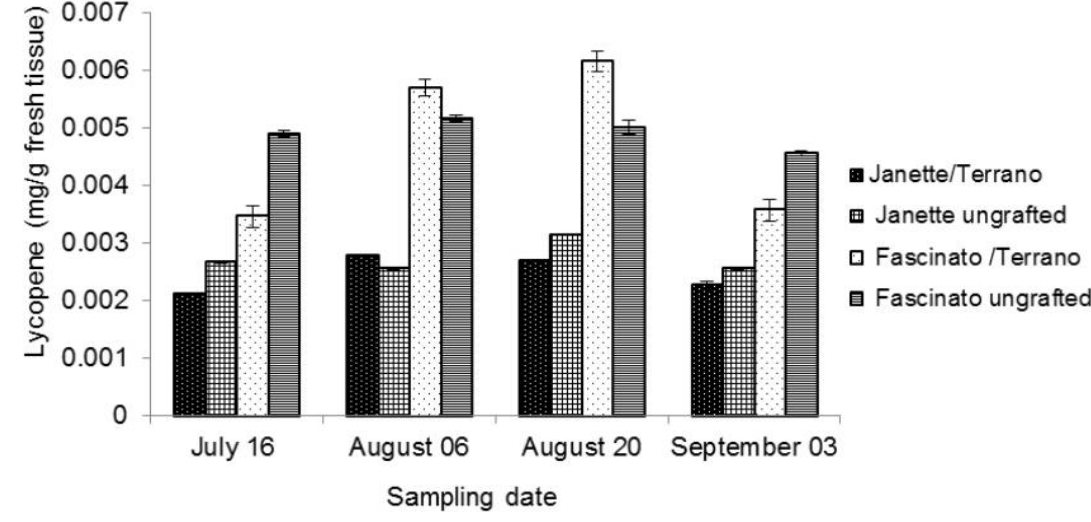
Figure 3. Lycopene concentration in two bell pepper varieties grafted and